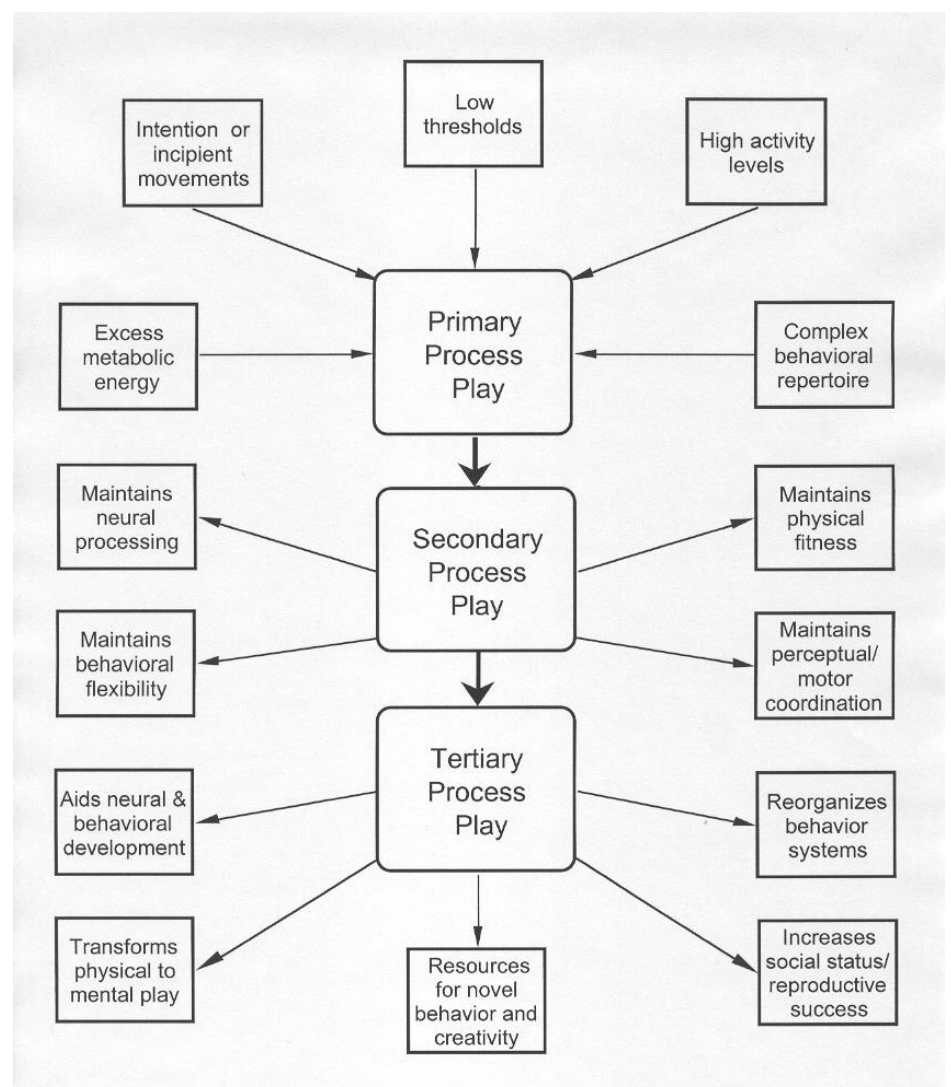
Figure 1. A scenario for the evolution of play depicting three play processes. Note that all three processes can occur in the same species and individual depending on setting, context, experience, etc. (from Burghardt,